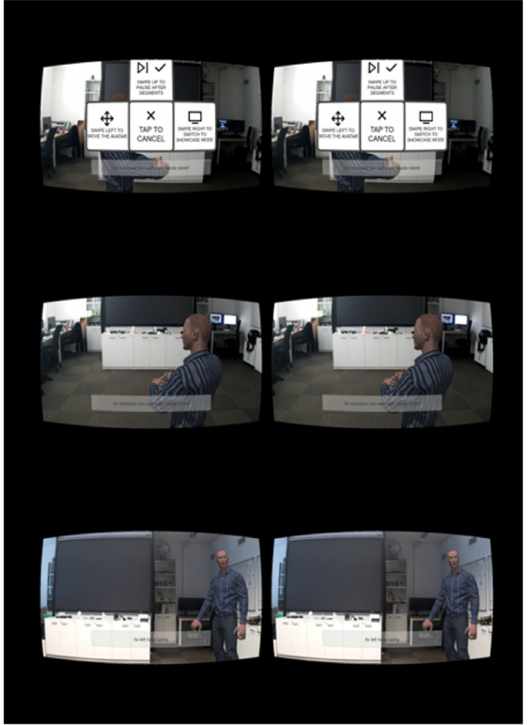
Figure 6. User interface from user’s perspective in